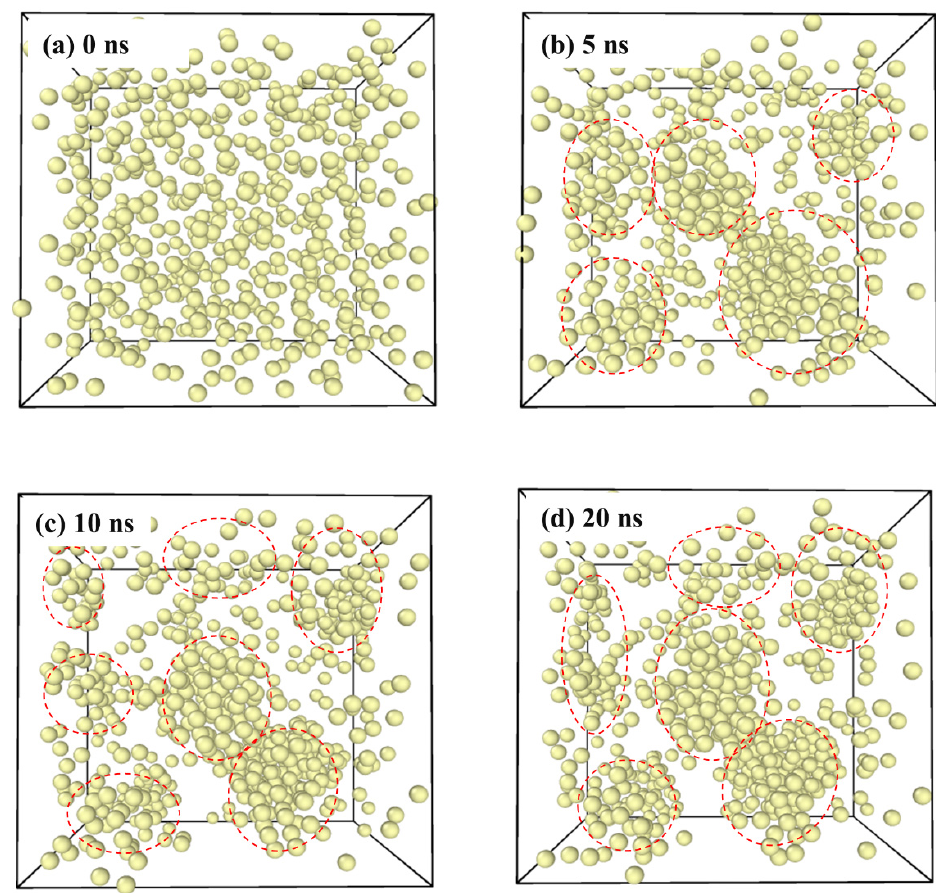
Figure 5. System evolution of Xe clusters at different times at 2500 K (the yellow balls represent Xe atoms, the red circles mark the clusters); ( a ) 0 ns, ( b ) 5 ns, ( c ) 10 ns, ( d ) 20 ns.